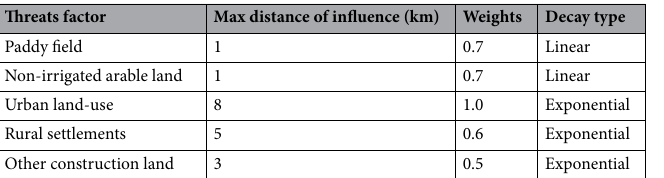
Table 2. Threat factors and maximum effect distances, weights of threat factors, and decay types identified in the study area.